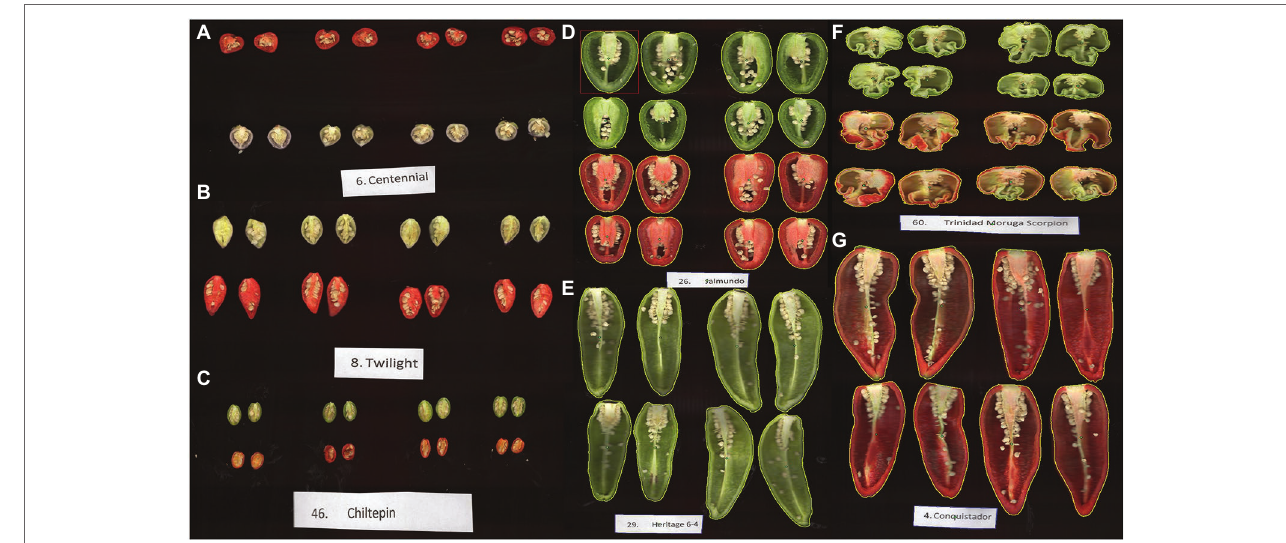
FIGURE 2 | Phenotypic diversity among chile pepper evaluated for fruit morphology-related traits using the Tomato Analyzer v.4.0 program. (A) “NuMex Centennial” and (B) “NuMex Twilight” ( C. annuum ) are ornamental chile peppers. (C) Chiltepins ( Capsicum annuum var. glabriusculum ), commonly known as “bird peppers,” are regarded as the progenitors of the cultivated C. annuum . (D) “NuMex Jalmundo” ( C. annuum ) is a large-sized jalapeño. (E) “NuMex Heritage 6–4” and (G) “NuMex Conquistador” ( C. annuum ) are both New Mexican pod-type chile peppers. (F) “Trinidad Moruga Scorpion” ( C. chinense ) is a “superhot” chile